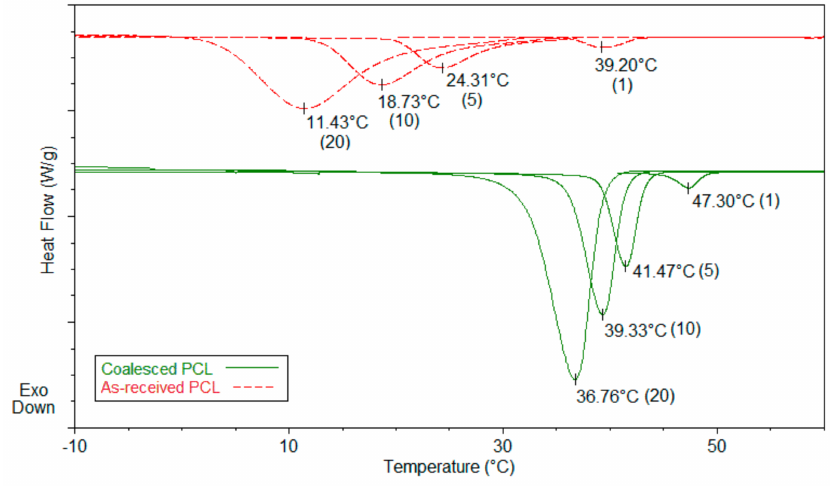
Figure 6. Melt-crystallization curves of as-received and coalesced poly( ε -caprolactone) (PCL) observed at 20, 10, 5, and 1 ◦ C / min cooling rates. Reproduced with permission from [25]. Copyright 2011 Elsevier